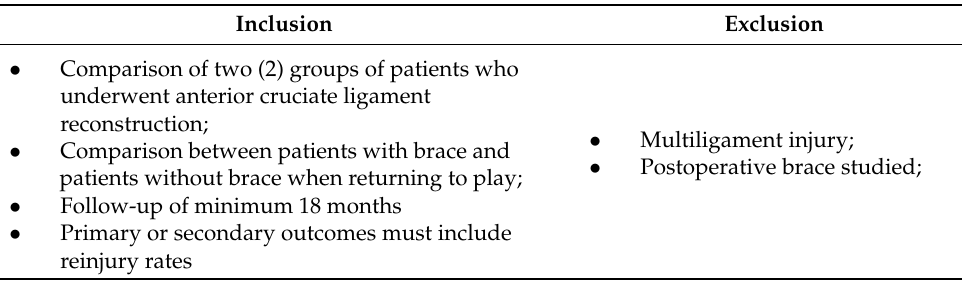
Table 1. Inclusion and exclusion criteria.